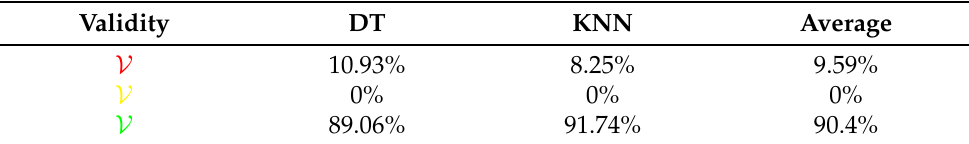
Table A2. Rate of validity of RHOASo vs. HPO across all D i (% with accuracy and time